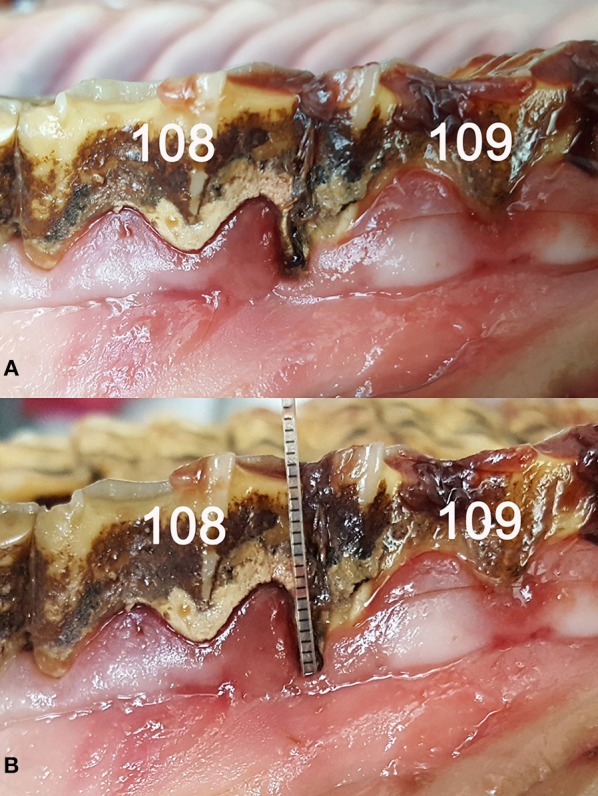
(A) Periodontal pocket between cheek teeth 108 and 109. (B) The inserted probe demonstrates the depth (5 mm) and position of the periodontal pocket.